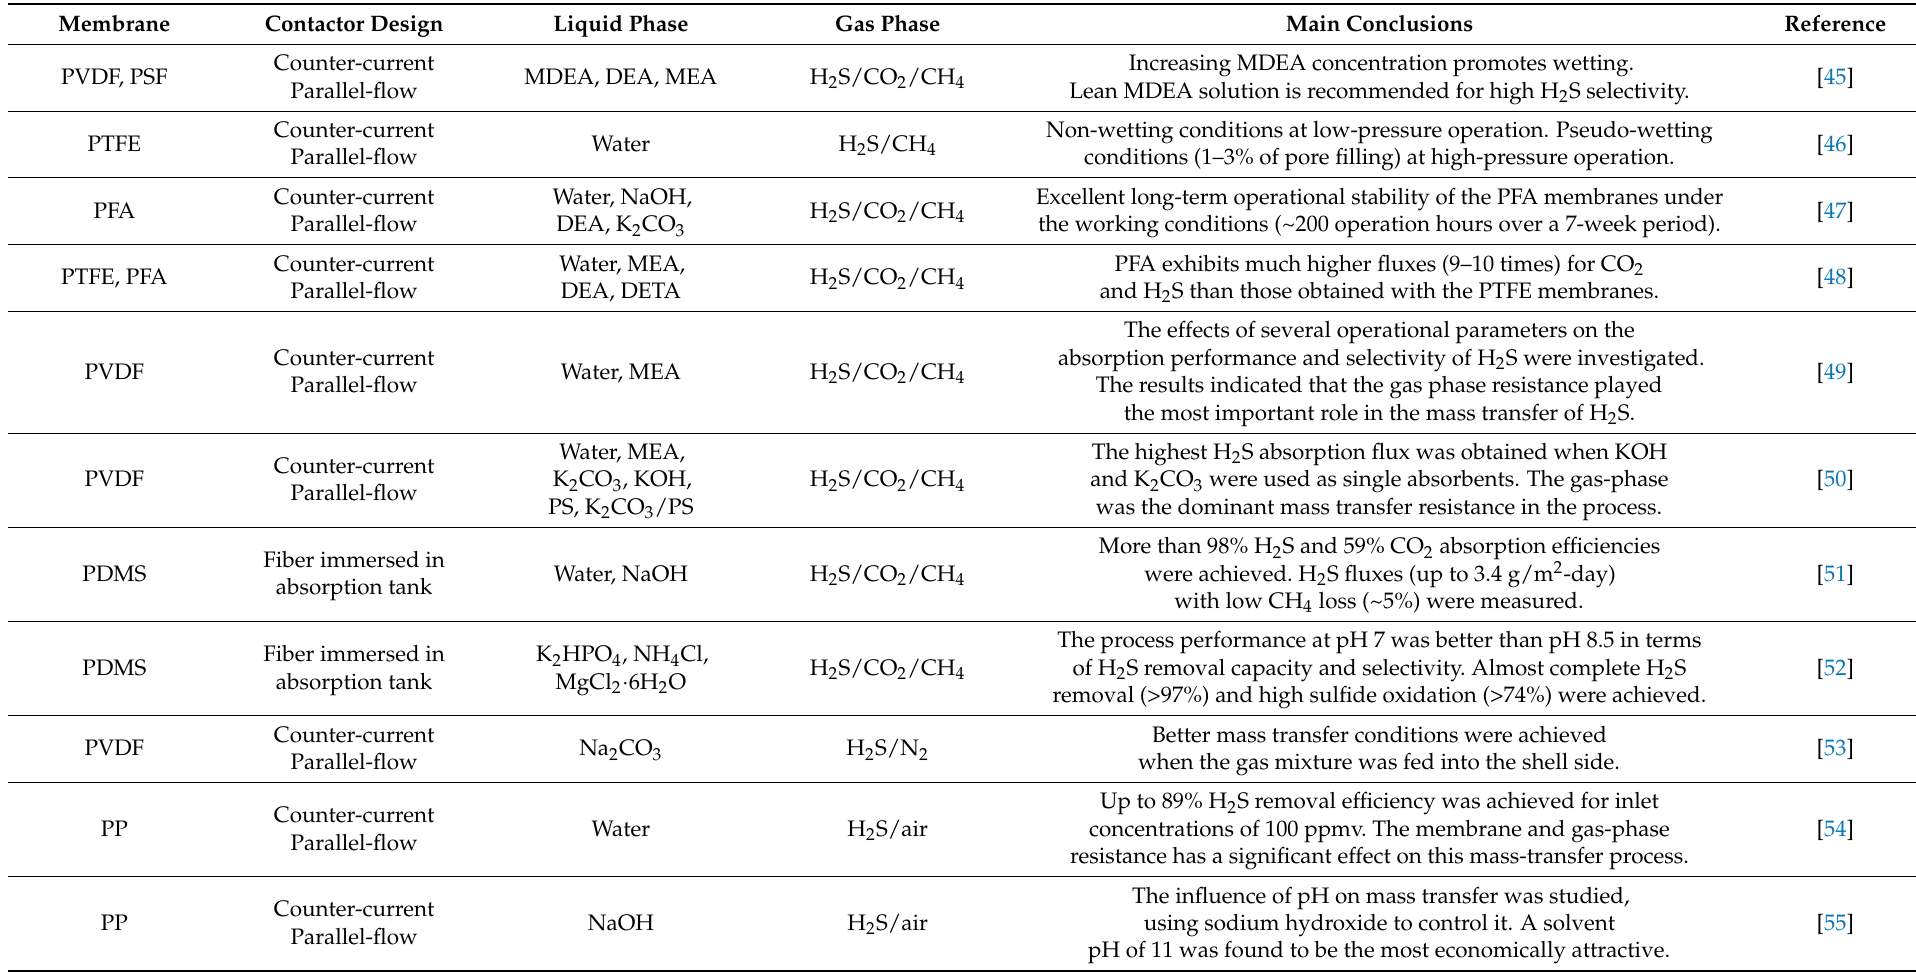
Table 7. Synopsis of the main results of literature studies on H 2 S removal through